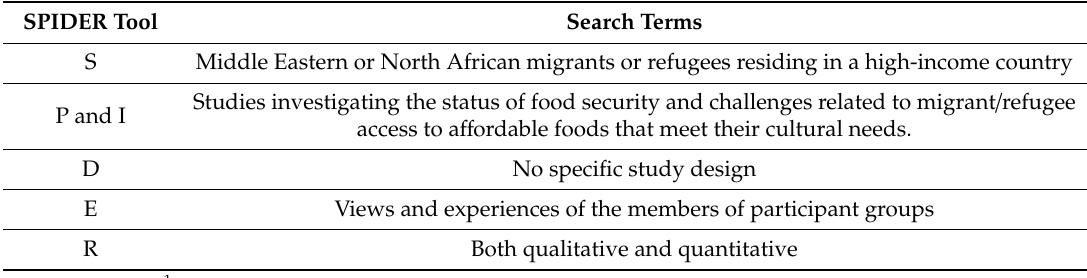
Table 1. Eligibility criteria according to SPIDER 1